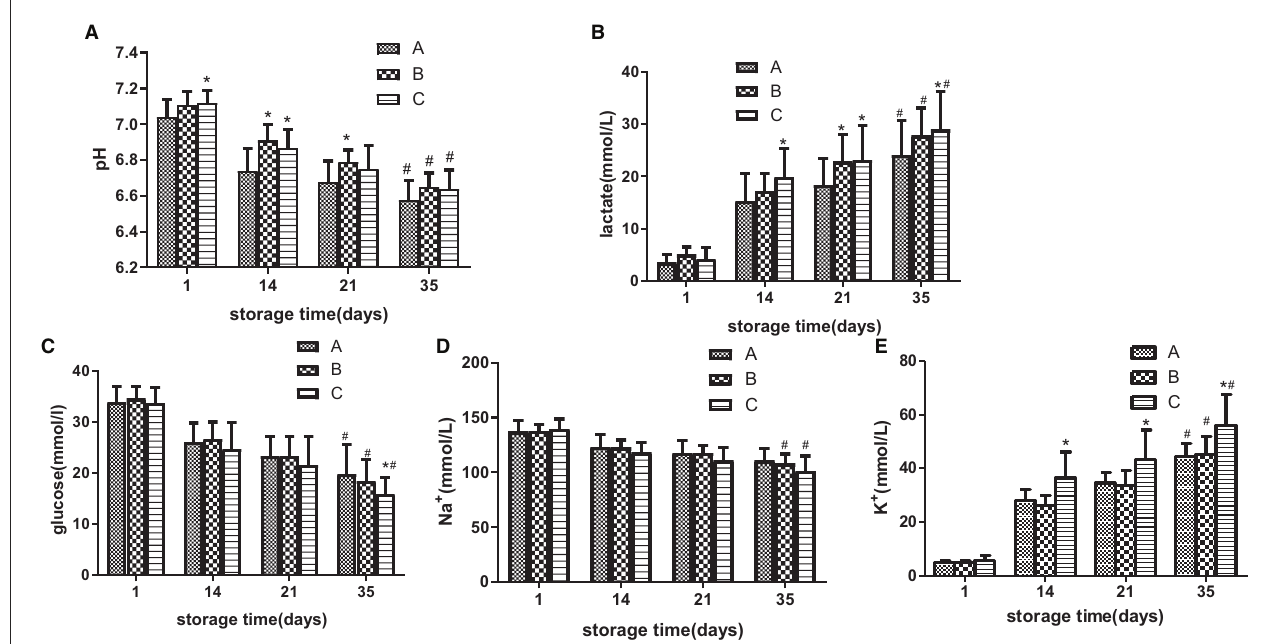
FIGURE3 During the storage period of 35 days, the standard quality parameters of suspended red blood cells (SRBCs) stored in different groups were measured. pH (A) , lactic acid concentration (B) , glucose concentration (C) Na + concentration in the supernatant (D) , and K + level in the supernatant (E) . *ANOVA p < 0.05 [ (A) p = 0.047, 4.91E-5, 0.004, 0.010, (B) p = 0.004, 0.014, 0.006, 0.012, (C) p = 0.009, (E) p = 9.83E-10, 0.001, 9.72E-5] in comparison to group A on days 1, 14, 21, and 35, respectively. # ANOVA p < 0.05 [ (A) p = 9.83E-10, 8.22E-10, 0.001, (B) p = 9.95 E-12, 8.87 E-12, 9.62 E-12, (C) p = 0.010, 0.006, 0.003, (D) p = 0.035, 0.026, (E) p = 8.84E-10, 9.21E-10, 9.43E-10] for all parameters on day 1 vs. day 35.